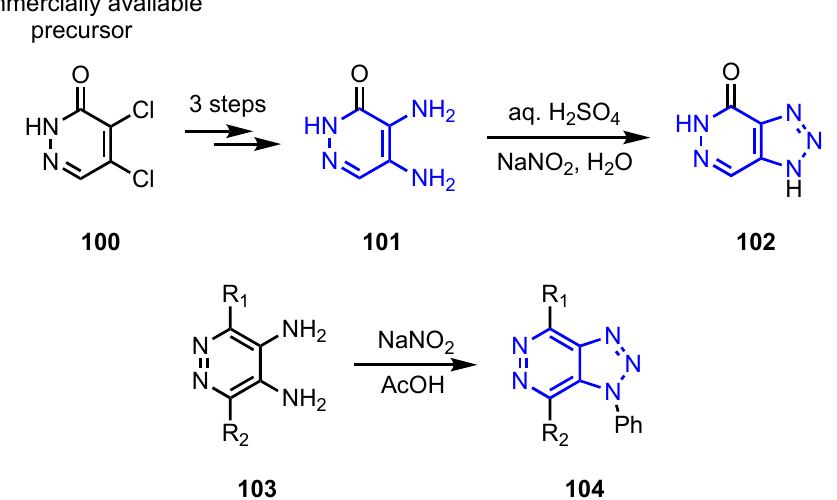
Scheme 27. Formation of 3,5-dihydro-4 H- 1,2,3-triazolo[4,5- d ]pyridaz-4-one 102 upon treatment of 4,5-diamino-6-pyridazone 101 with nitrite, and a similar reaction of diaminopyridazine 103 cyclizing to 104 with nitrite. (R 1 = H, O-alkyl, SH, SCH 3 , OH, NH 2 , R 2 = H, CH 3 , O-alkyl, OH,